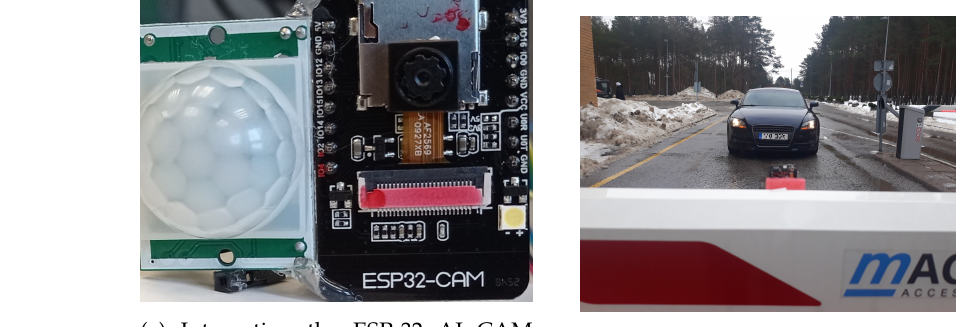
Figure 4. Detection and Vision Node at the perception layer.